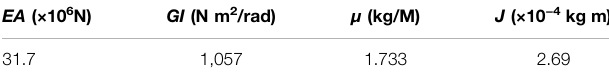
TABLE 2 | Physical and mechanical parameters of the iced